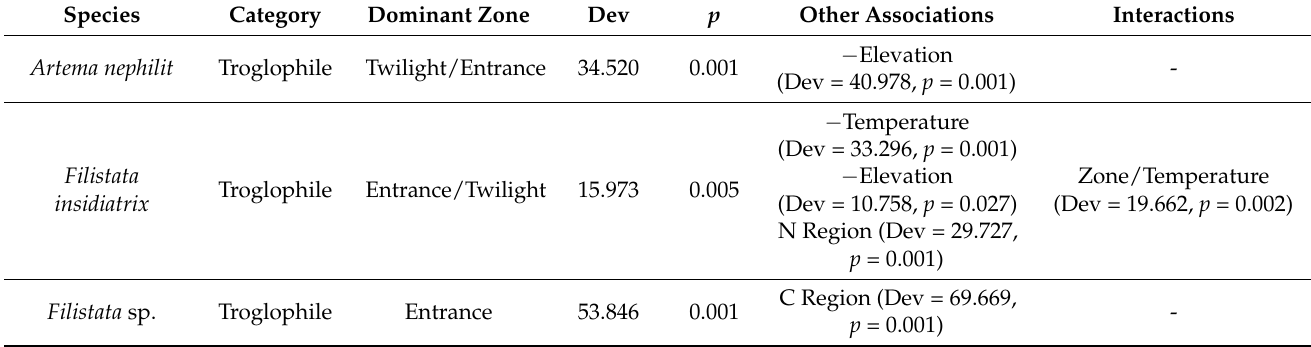
Table 1. Significant univariate MGLM results for the 14 species with significant associations with cave zones, or with interactions between cave zones and other variables; deviance and probability are given for each. Other significant variables are listed, as well as interactions between zone and those variables. For the other associations, the nature of the association is given as + or − for positive or negative associations, respectively, and “N”, “C”, and “S” are given for prevalence in north, central, or southern geographical regions, respectively. The “category” column denotes whether that species is troglobite, troglophile, or accidental (see Gavish-Regev et al., 2021 [19] for the assignment of species to categories). The “dominant zone” column denotes the ecological zones(s) in which the species was mostly commonly found. The abundance of these spiders across different cave zones is visualised in Figure 6. For spiders with significant associations with interactions between cave zone and other variables, but not with the cave zones themselves ( n = 3), the deviance and probability are given in